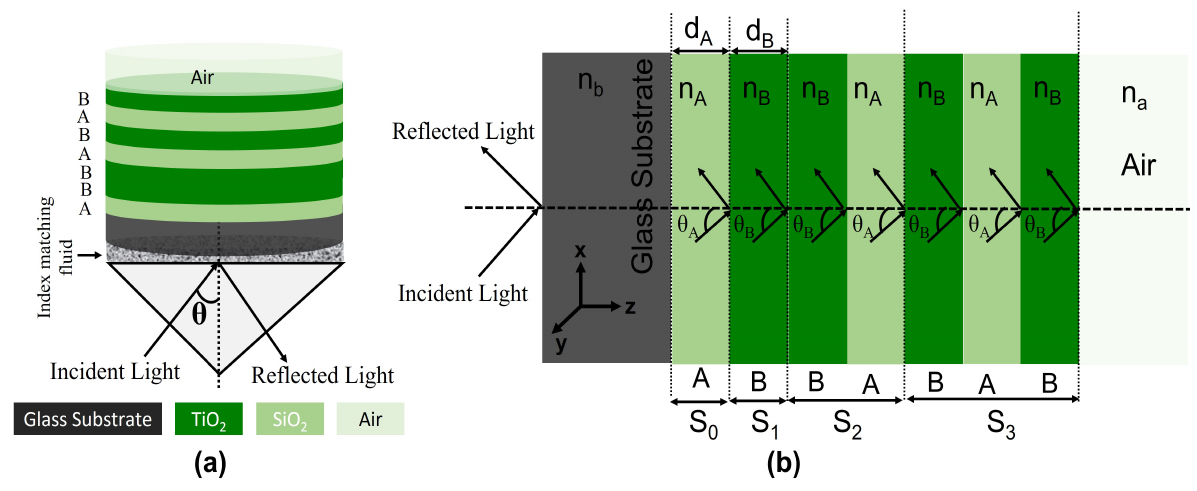
Figure 1. Schematic illustration of proposed quasiperiodic photonic crystal structure to analyze interface mode localization, ( a ) 3D representation and; ( b ) 2D representation of starting four elements. Table 1. The first six members of the considered QPhC design.